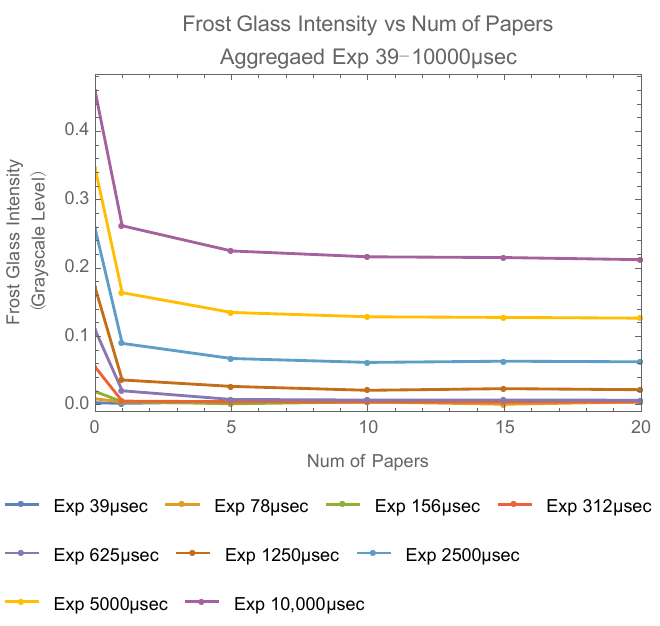
Figure A2. Frost glass intensity. As the number of the filter papers increases, each grayscale level approaches a con- stant value. From Figure A2, this value is confirmed to be monotonically increasing with exposure time. This is regarded as the background. Let n be the number of filter papers